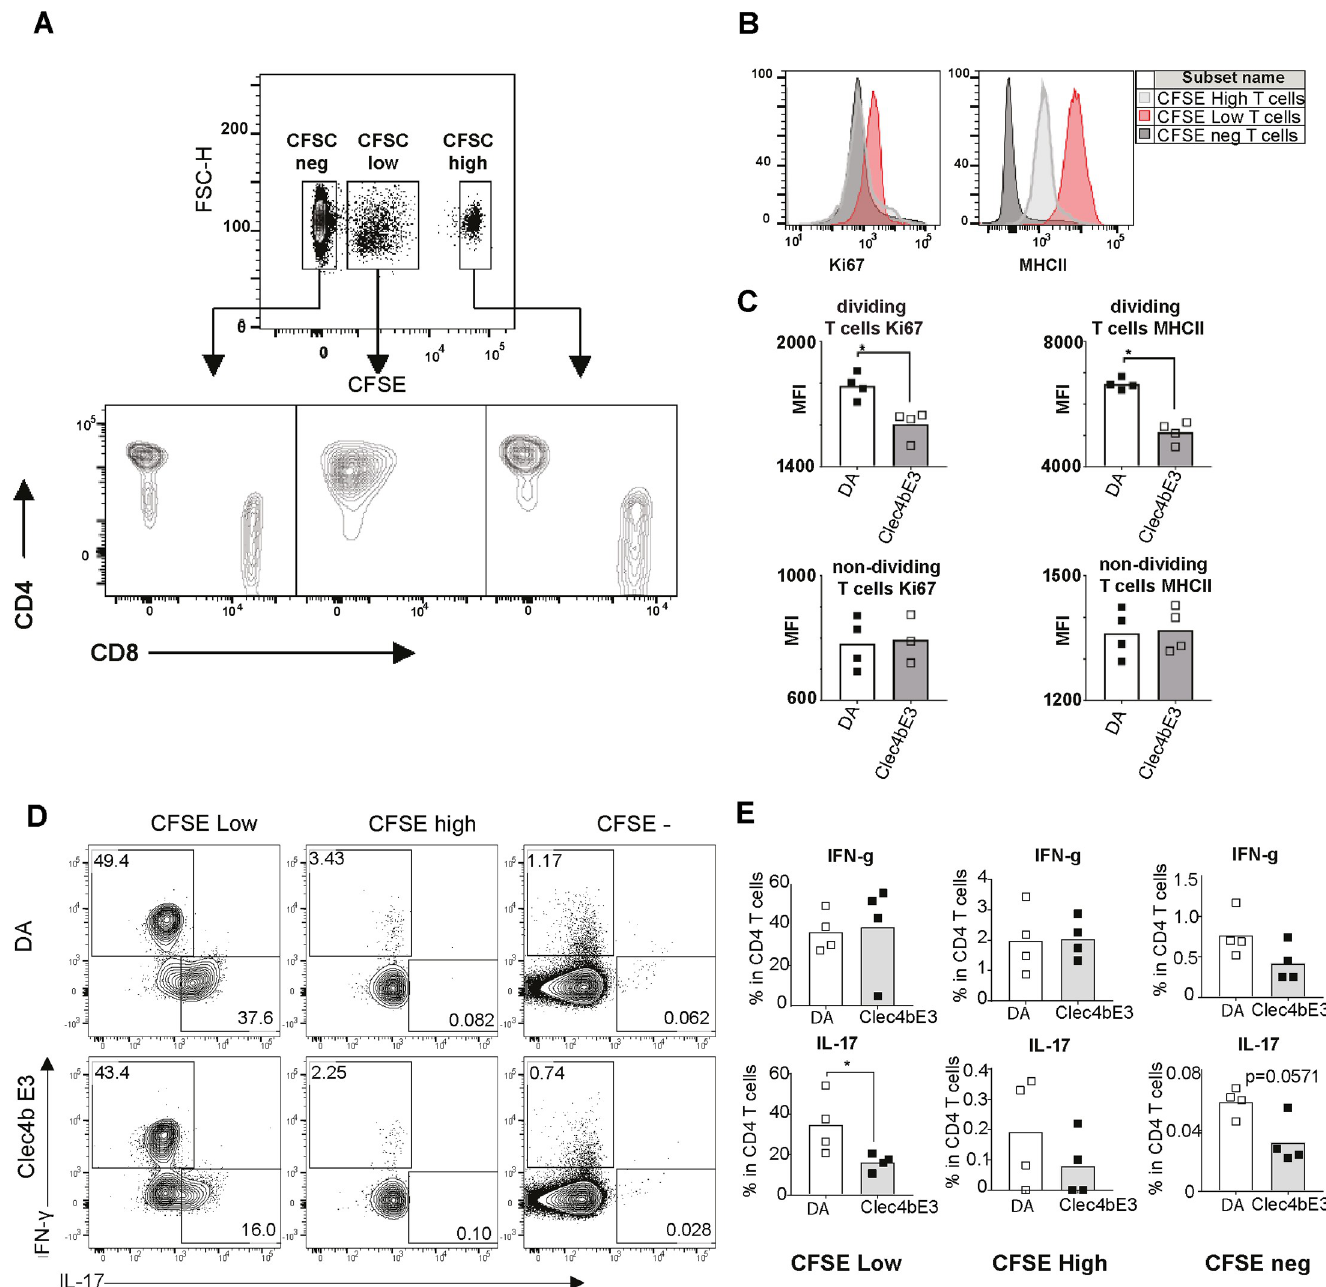
Fig 7. Clec4b regulate T cell proliferation also in vivo and the activation correlate with down-regulation of IL17 production. DA rats were injected intradermally with oil and 4 days later the spleens were used as a source of oil primed T cells. These were CSFE labeled and injected intravenously into na ï ve DA and Clec4b E3 recipients that had been injected intradermaly with mineral oil the same day. a) Proliferation FACS plot describing CFSE intensity in CD4 versus CD8 T cells harvested from spleens of the recipients day 3 after oil injection. CFSE negative T cells are the recipient endogenous T cells. The CFSE high are the non-proliferating T cells from the donors and the CFSE low are the donor T cells that have been proliferating in the recipient. b) Histogram over the distribution of the three groups from a and how they differ in the expression of both Ki67 and MHCII on their surface. c) Graphs describing how the two donor groups, non-dividing and dividing T cells, differ in the expression of MHCII and Ki67 between DA and Clec4b E3 recipients. d,e) Illustration on how the expression of the two cytokines IFNg and IL17 is distributed between the three groups of differentially proliferating T cells between the Clec4b sufficient and deficient recipient rats. d) Illustrative FACS plot.